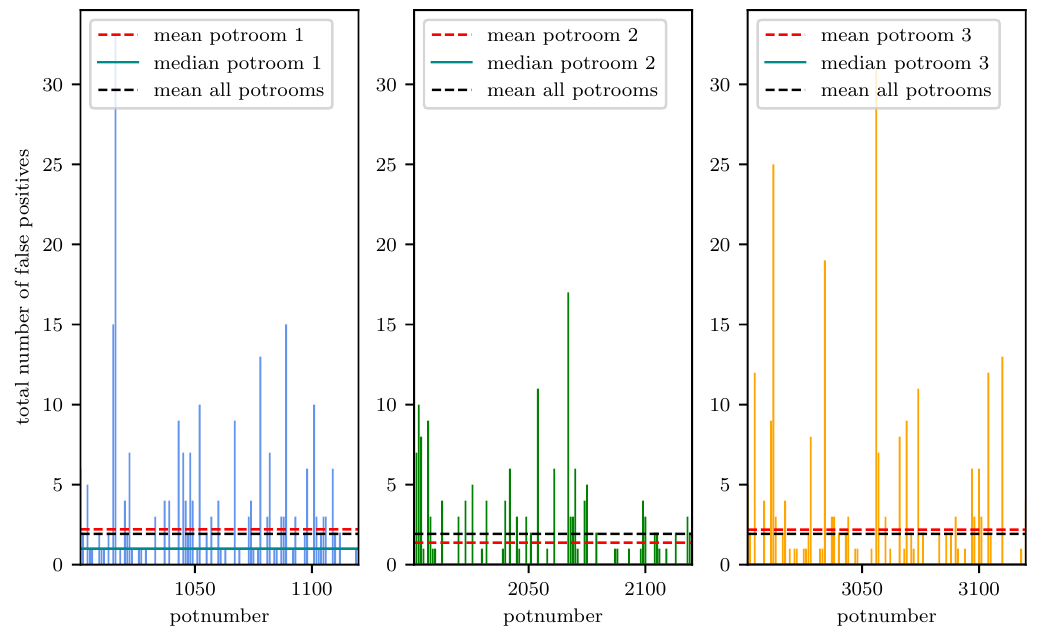
Figure 7. Distribution of false positives dependent on potnumber.